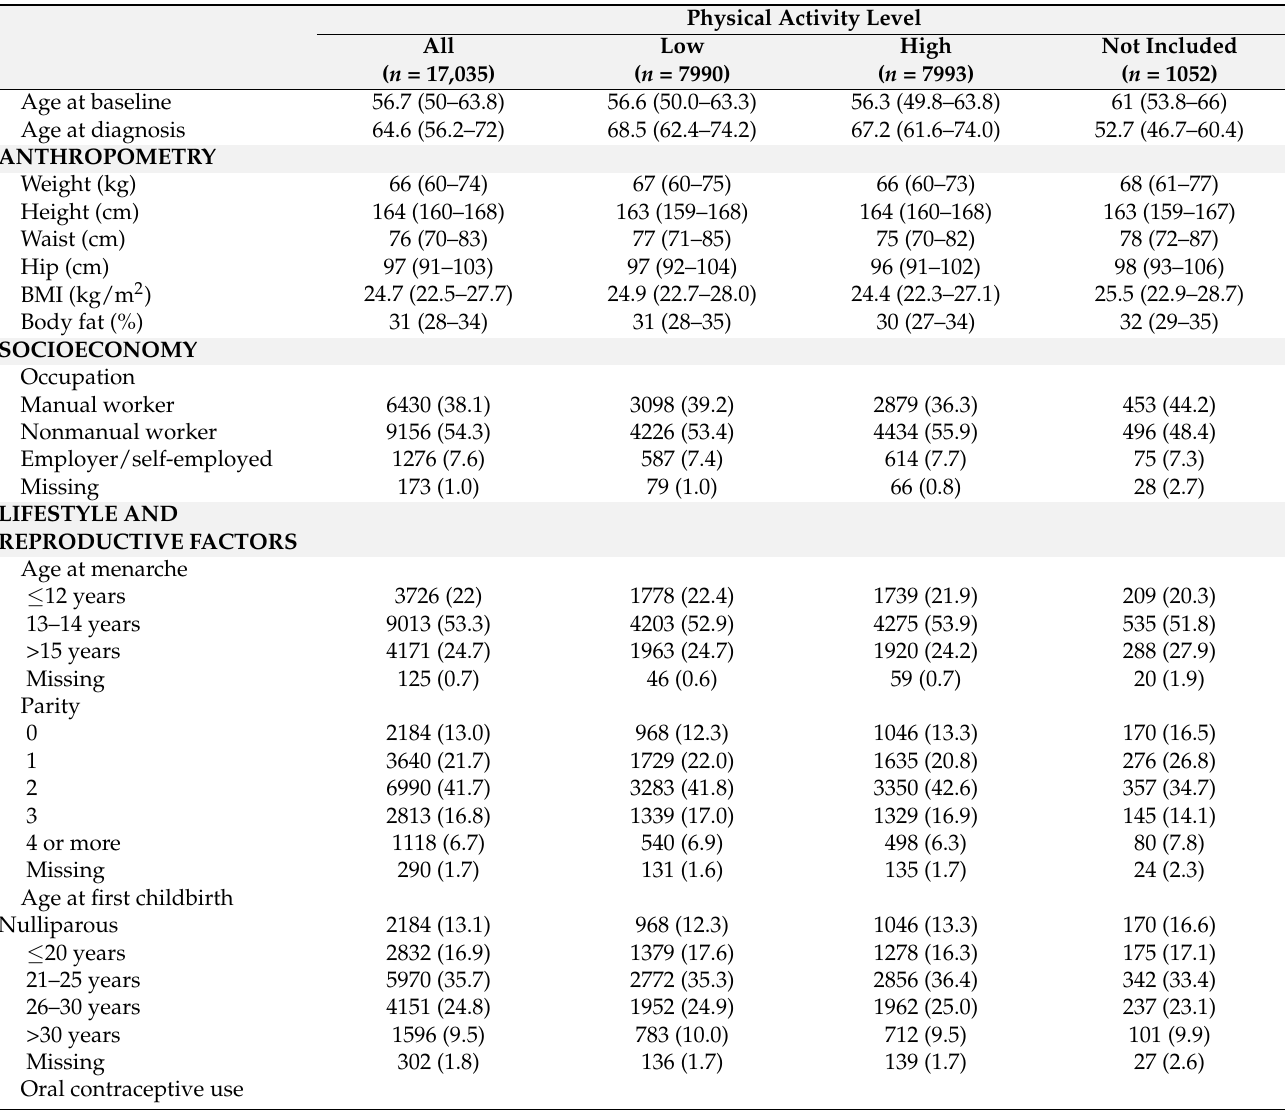
Table 1. Distribution of established and potential risk factors for breast cancer at baseline among included and excluded